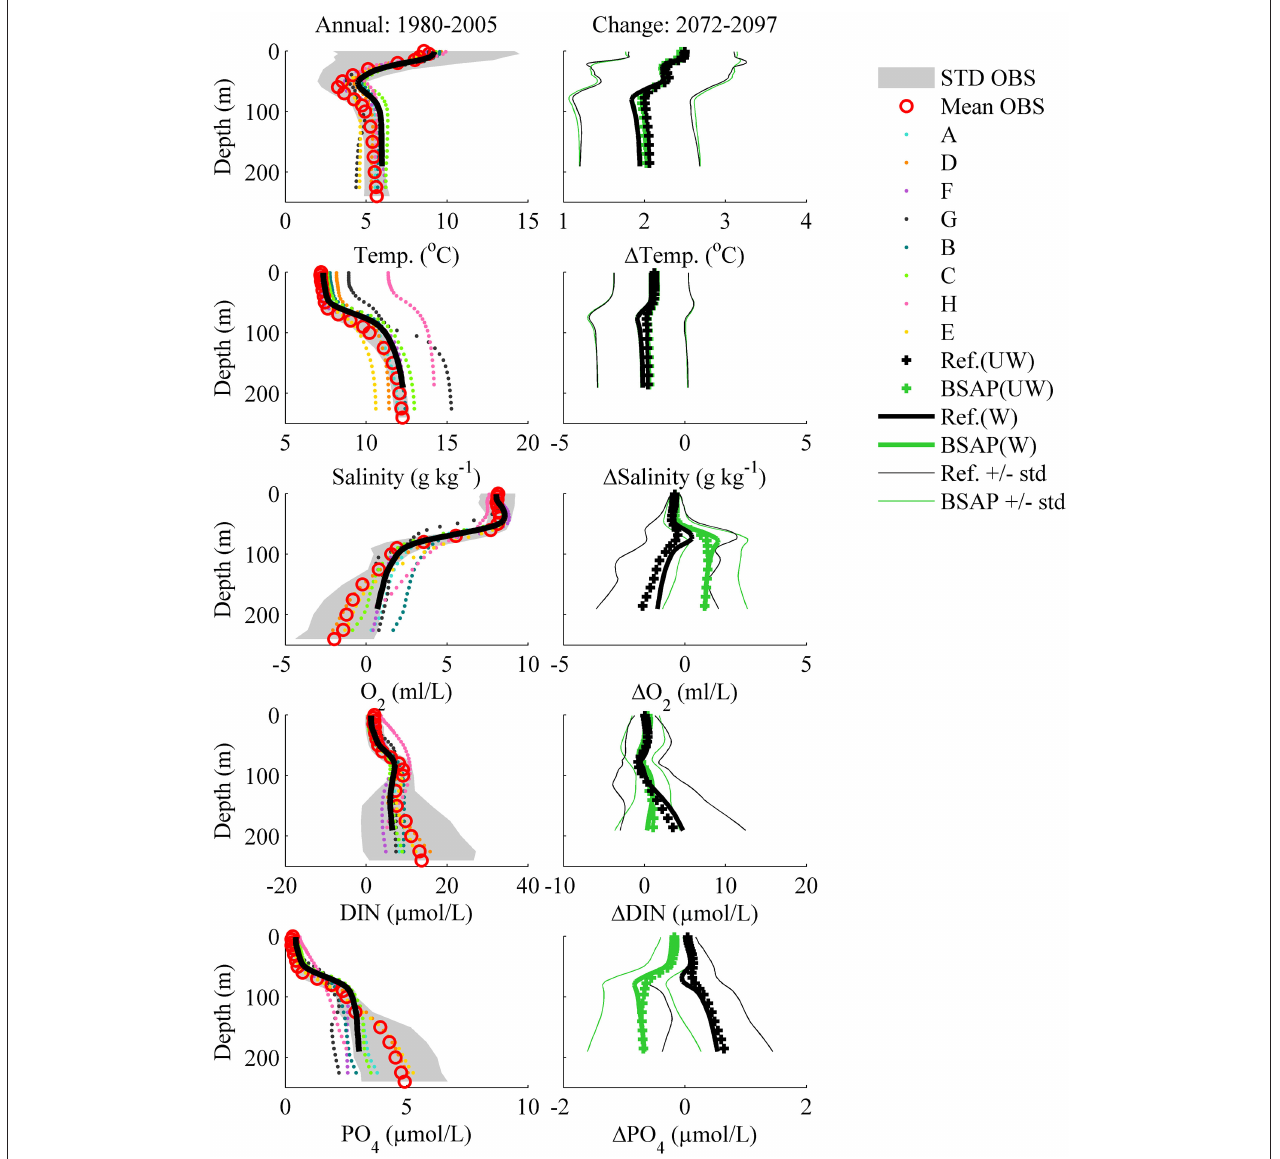
FIGURE 10 | Mean observed and simulated profiles in the control runs for each variable and each Model A to H at Gotland Deep (BY15) for the period 1980–2005 (left panels). The ensemble mean value (thick black line) is calculated from the weighted model results. In addition, the unweighted (plus signs) and weighted (thick solid lines) ensemble mean changes and standard deviations between the future (2072–2097) and present (1980–2005) climates in REF and BSAP scenario simulations are shown (right panels). Standard deviations are calculated from the two ensembles without